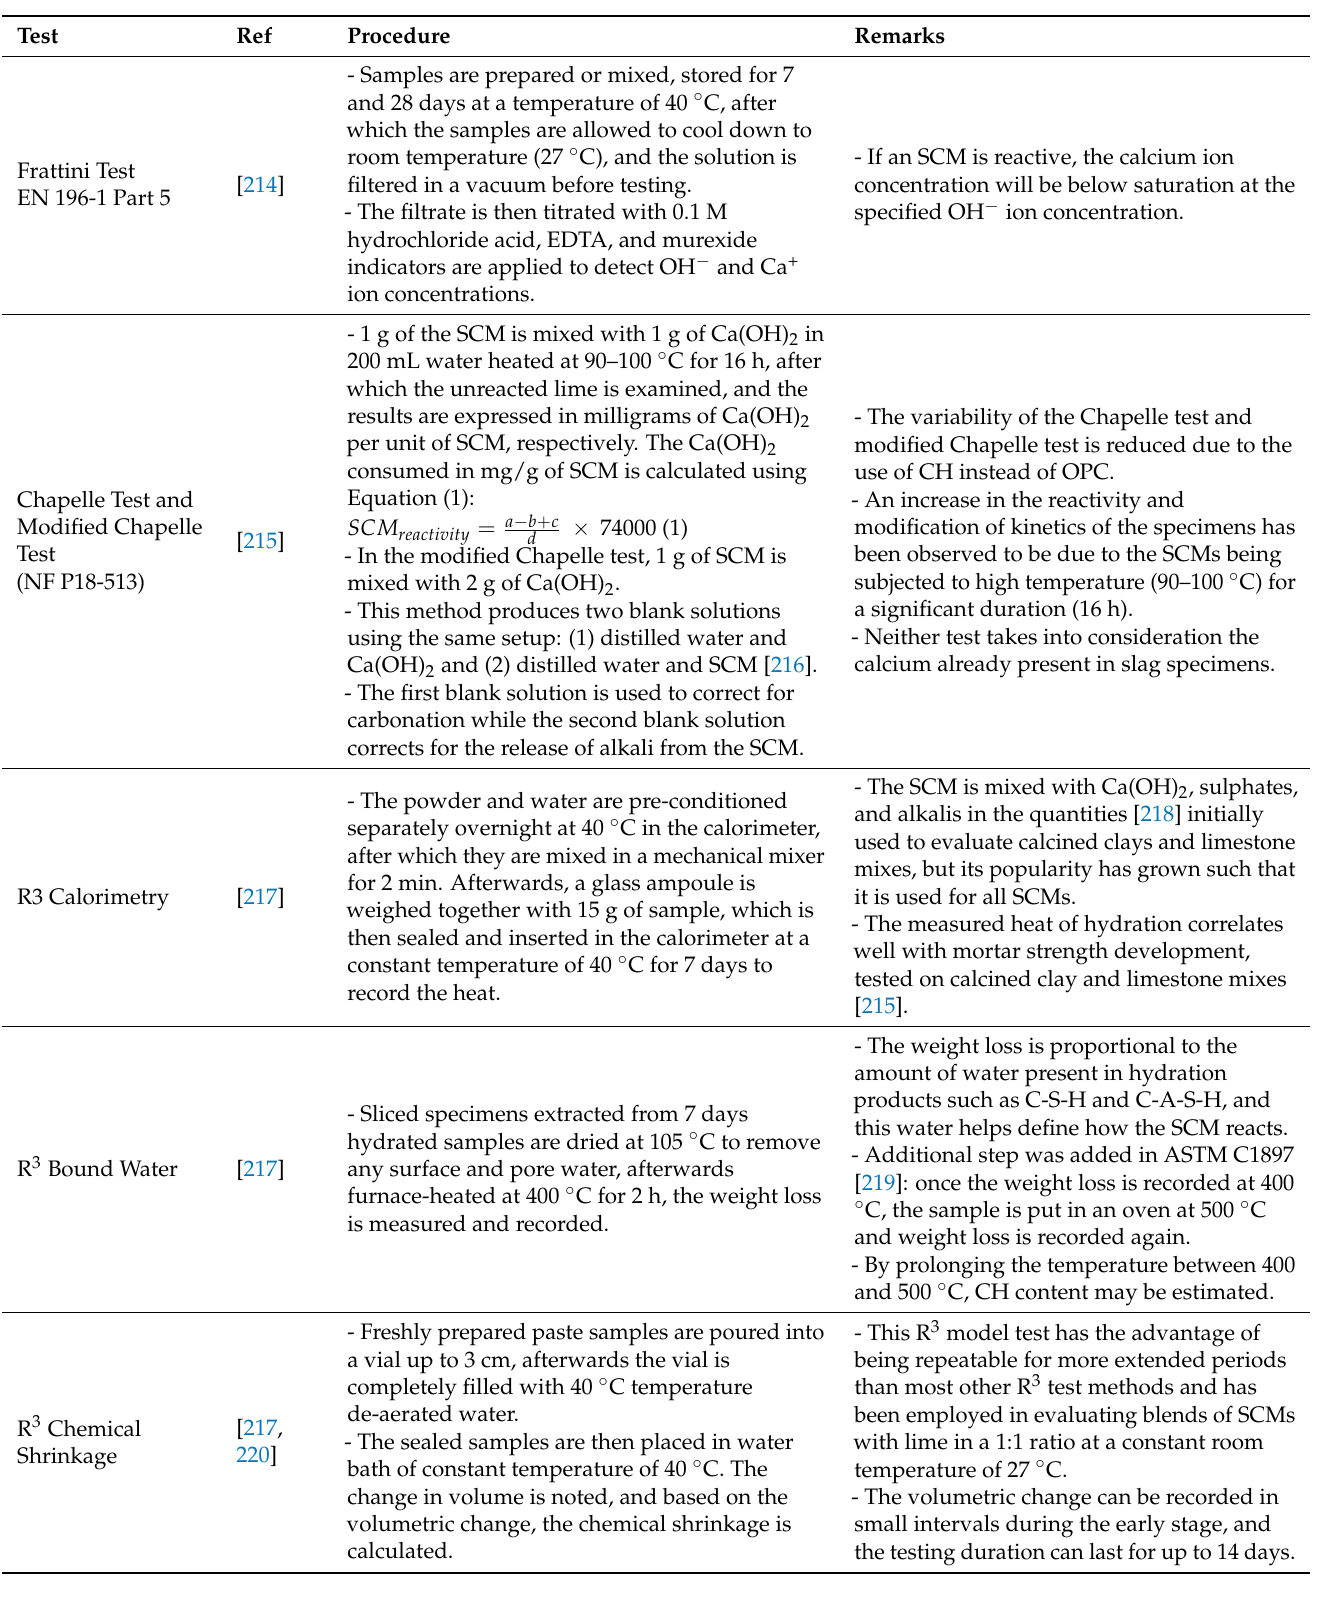
Table 17. Different reactivity test methods for